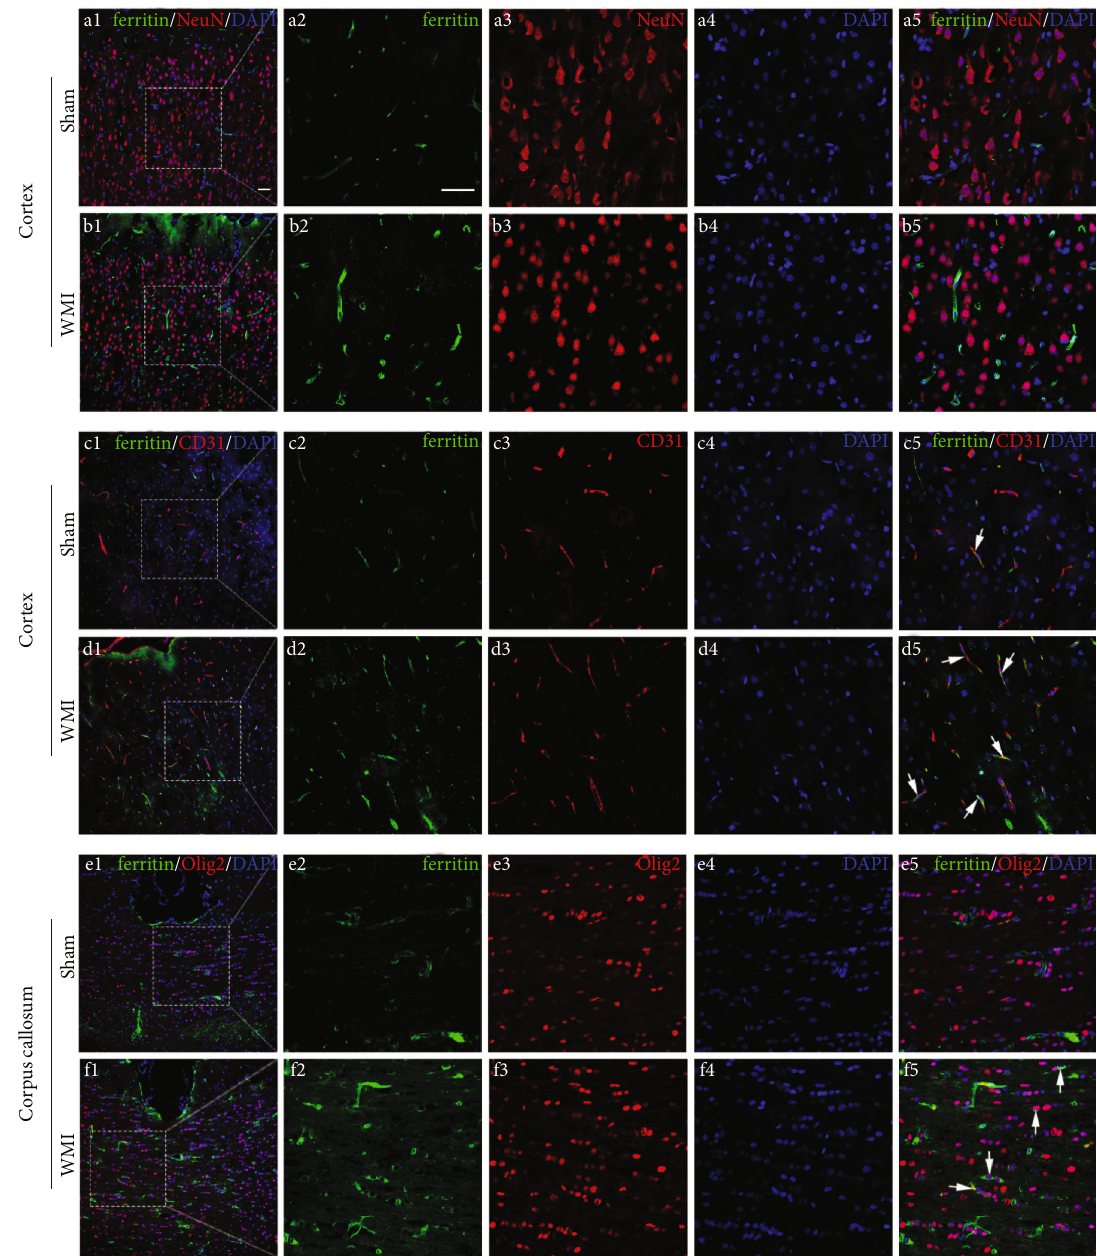
Figure 5: Representative images of immuno fl uorescence staining for ferritin (green), NeuN (neuronal marker; red)/CD31 (vascular marker; red)/Olig2 (oligodendrocyte marker; red), and DAPI (nuclear marker; blue) in rat brains on POD 28. Ferritin-positive cells were colocalized with CD31- or Olig2-positive cells; however, they were largely observed in the WMI group than in the sham group. White arrows indicate ferritin + CD31 + cells in c5 and d5 and ferritin + Olig2 + cells in f5. Scale bar, 50 μ